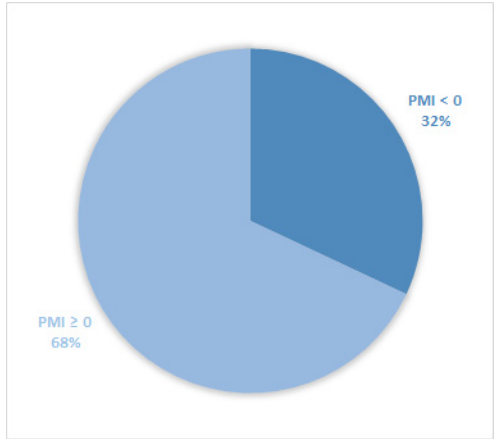
Figure 3. Pie chart displaying the percentage of patients with PMI < 0 and PMI ≥ 0. Only patients undergoing palliative radiotherapy were included (791).